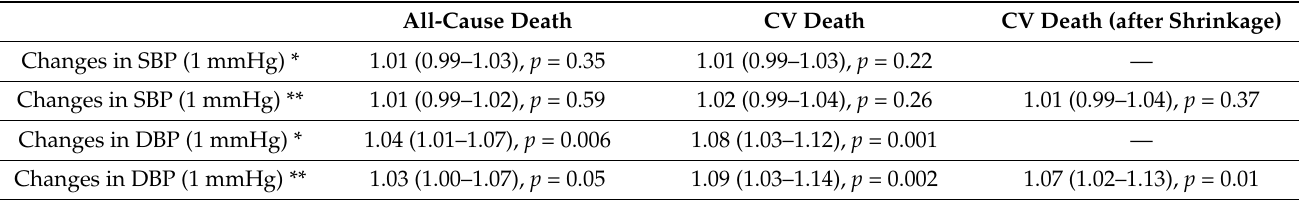
Table 2. Survival analysis showing the association between changes in DBP and all-cause and CV death.